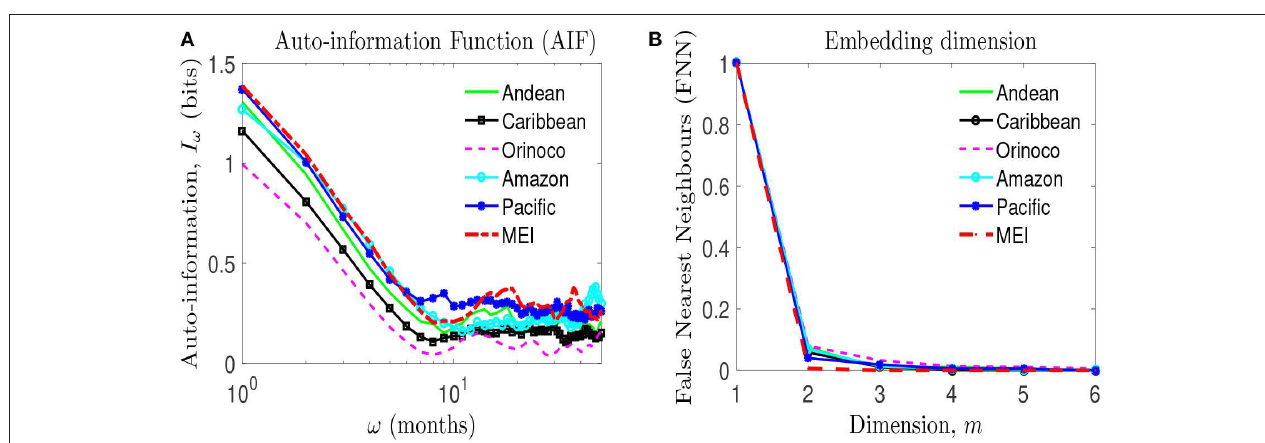
FIGURE 7 | Estimation of the time delay and the embedding dimension for monthly precipitation averaged over the natural regions of Colombia (from data set No. 1) and MEI index. (A) Time delay, ω , using the auto-information function (AIF). (B) Embedding dimension, m , using false nearest neighbors